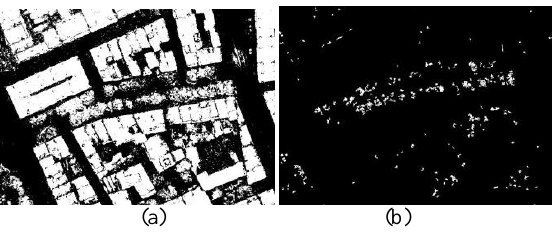
Figure 2: Off-ground region for the DSM of Figure 1a (a) and filtered vegetation